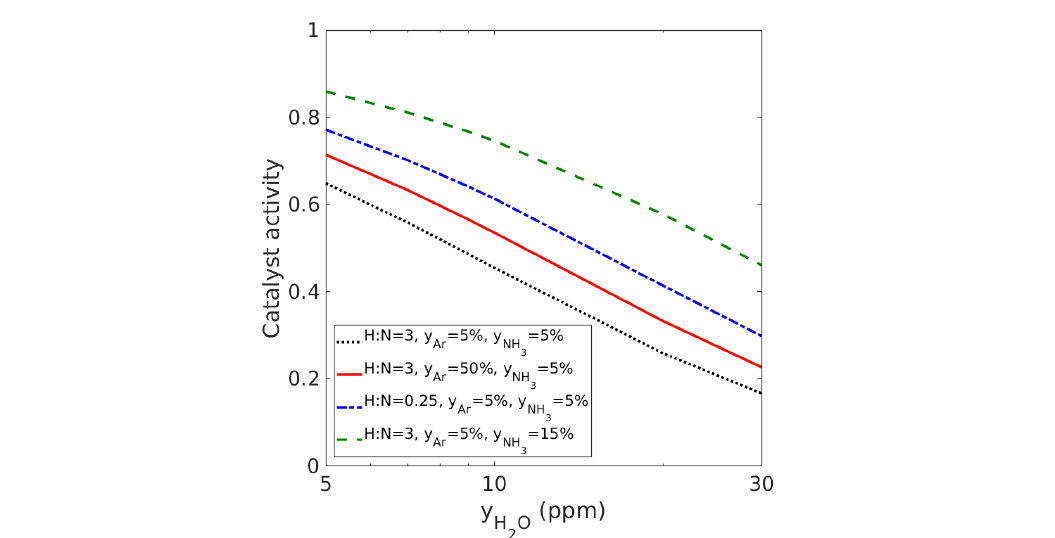
Figure 6. Change of catalyst activity for different gas compositions versus water content at P = 150 bar and T = 700